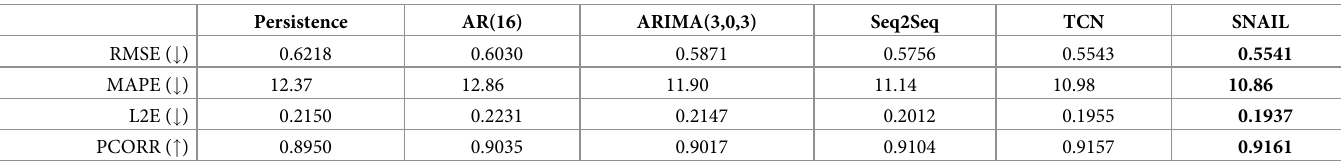
Table 3. The best performances achieved by Persistence, AR(16), ARIMA(3,0,3), Seq2Seq, TCN, and SNAIL for one-week-ahead forecasts. The performance metrics are averaged over 49 states. The symbols # and " indicate that the lower and higher values correspond to the better performance. Persistence